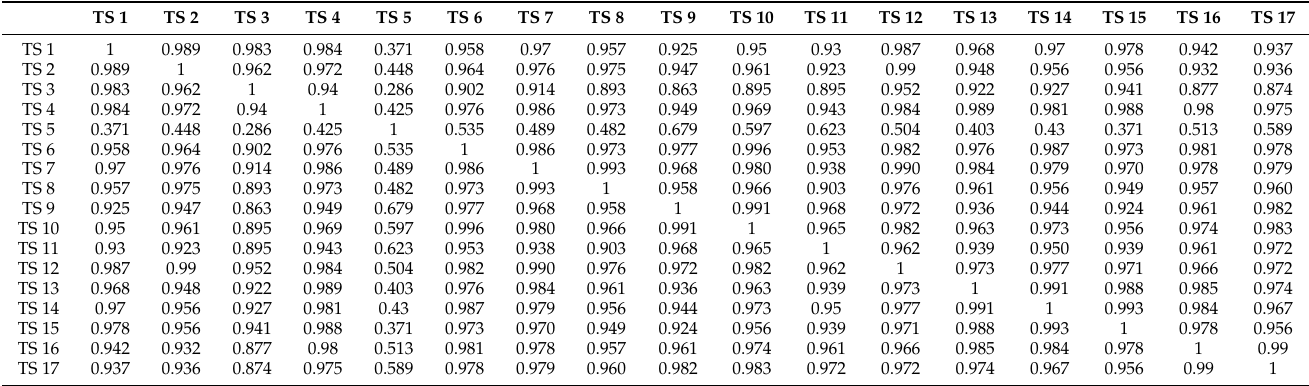
Table 1. Pearson correlation